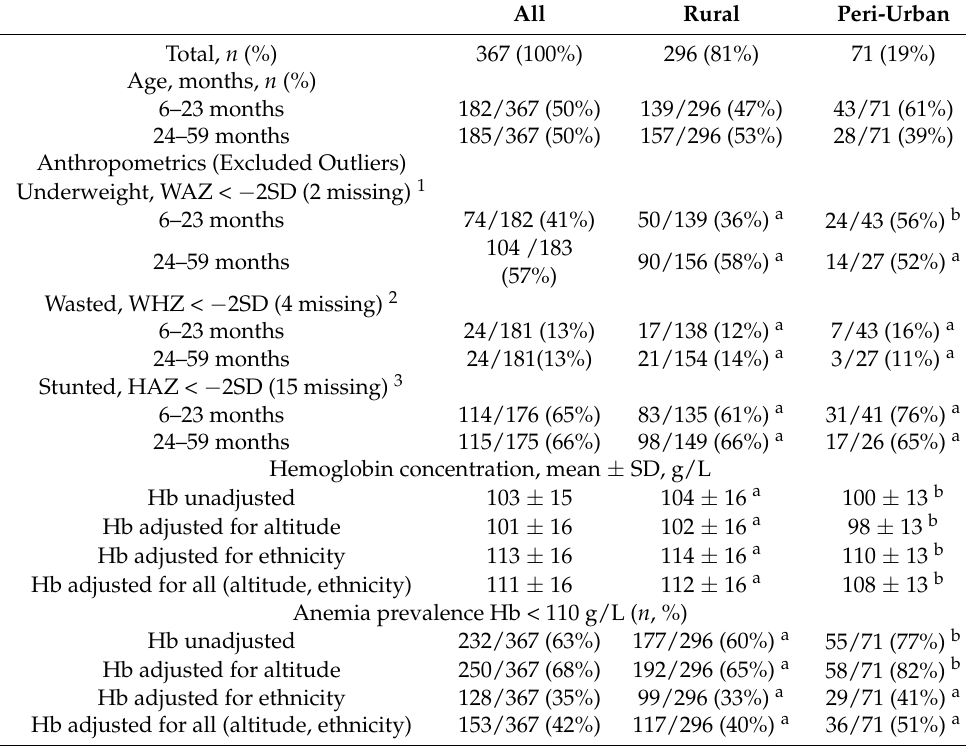
Table 3. Prevalence of childhood malnutrition and anemia among San children (6–23 and 24–59 months). All Rural Peri-Urban Total, n (%) 367